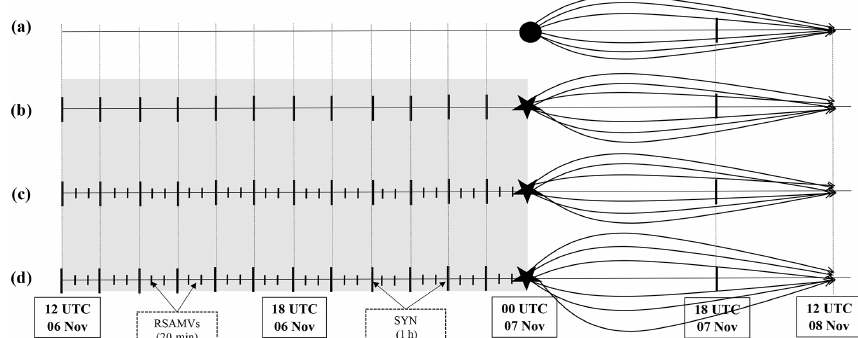
Figure 6. Schematic representation of the different numerical experiment designs performed in this study. (a) NODA, (b) SYN, (c) RSAMV and (d) CNTRL DA experiments. The shaded area corresponds to the assimilation windows between 12:00UTC, 6 November, and 00:00UTC, 7 November, where observations are assimilated. The black dot represents the initiation time of the forecast for the NODA experiment. Black stars represent the final analysis obtained from the different DA experiments and from which the subsequent free forecast is